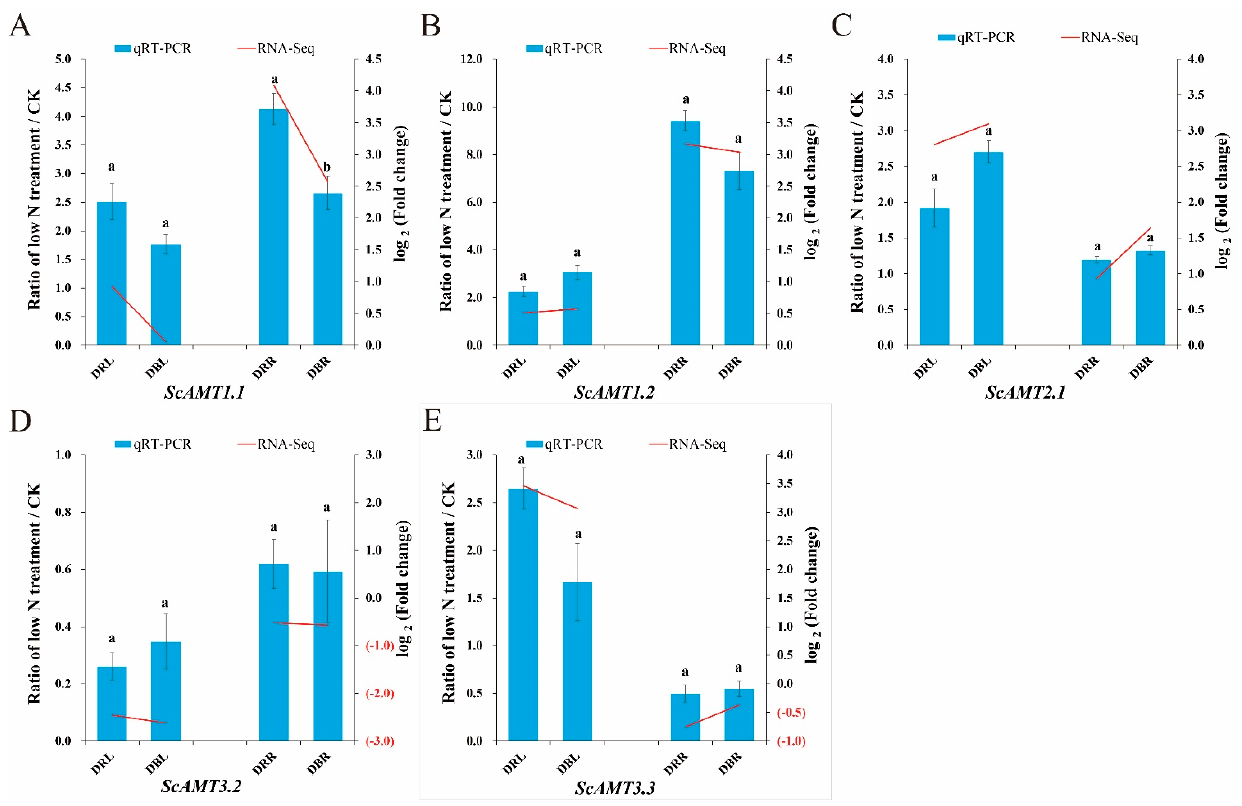
Figure 1. The expression patterns of the five AMT family DEGs between two sugarcane cultivars with contrastive NUE under low N condition. Notes: ( A – E ) represent the expression patterns of ScAMT1.1 , ScAMT1.2 , ScAMT2.1 , ScAMT3.2 , and ScAMT3.3 , respectively. The expression patterns determined by qRT-PCR (the ratio of DEGs expression level between low N treatment and their control groups, Ratio of low N treatment/CK) and RNA-Seq (in log 2 Fold change) are shown on the left and right sides in the same figure, respectively. DRL and DBL (RLT vs. RLCK, DRL. BLT vs. BLCK, DBL) mean the DEGs in the leaves of ROC22 and Badila under low N treatment (0.6 mM N) for 6 h vs. 0 h (used as control), respectively. DRR and DBR (RRT vs. RRCK, DRR. BRT vs. BRCK, DBR) mean the DEGs in the roots of ROC22 and Badila under low N treatment (0.6 mM N) for 3 h vs. 0 h (used as control), respectively. Error bars represent ± standard error from the mean of three biological replicates. Different letters above columns indicate significant differences ( p <